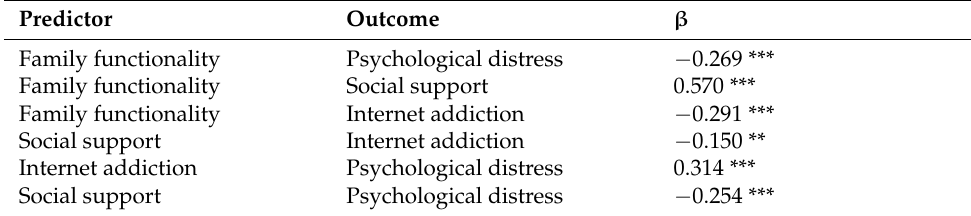
Table 3. Coefficients of path analysis.